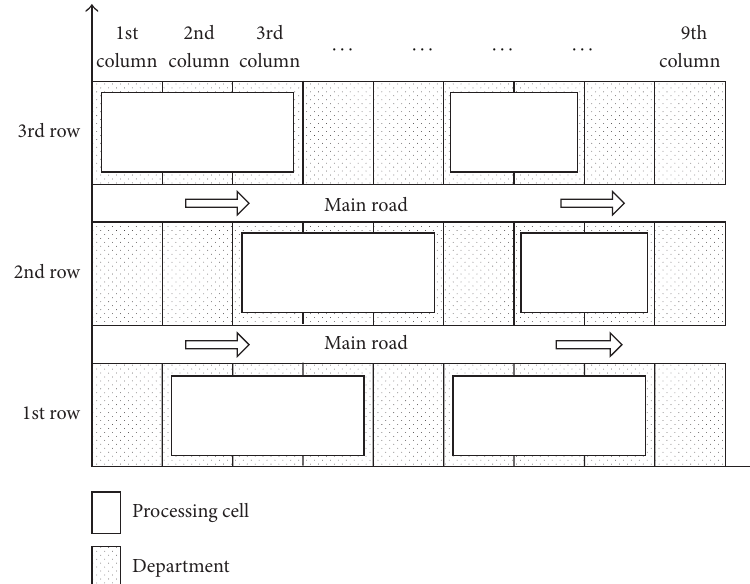
Figure 2: An example of a facility layout configuration with 3 rows, 27 departments, and 6 processing